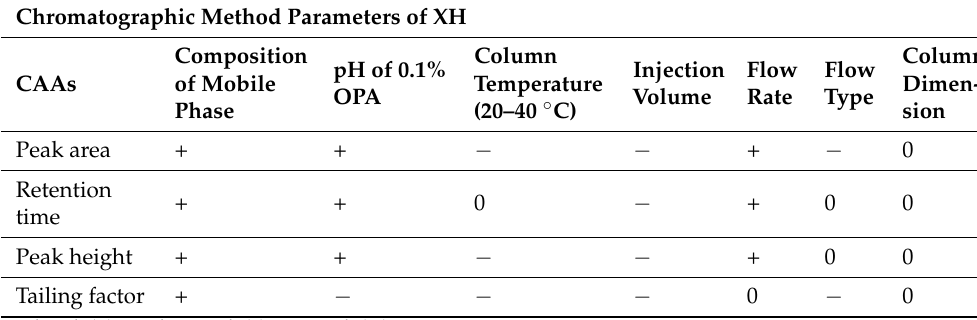
Table 1. Risk assessment parameters for developing the robust analytical